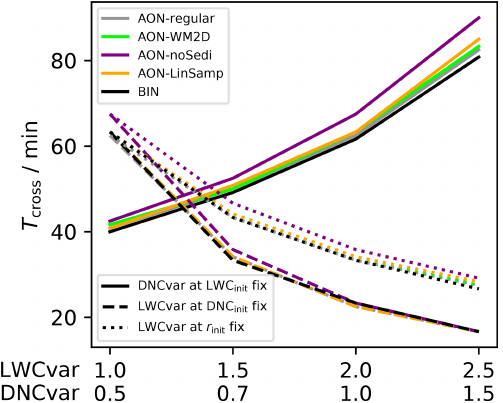
Figure 7. BoxModelEmul set-up: sensitivities to the initial size dis- tribution parameters LWC init , r init and DNC init are summarised by showing T cross , which is defined as the time when λ 0 drops be- low 10 7 m − 3 . LWC init is varied (the x axis shows the scaling fac- tor LWCvar relative to the default LWC init ) for either fixed DNC init (dashed lines) or r init (dotted lines). The solid lines depict a DNC init variation for fixed LWC init . Again, the scaling factor DNCvar is de- picted on the x axis. Five different model versions, as indicated in the top-left legend, are used: regular AON (reg), AON-WM2D, reg- ular AON with noSedi (“nS”), AON with LinSamp (“LS”) and